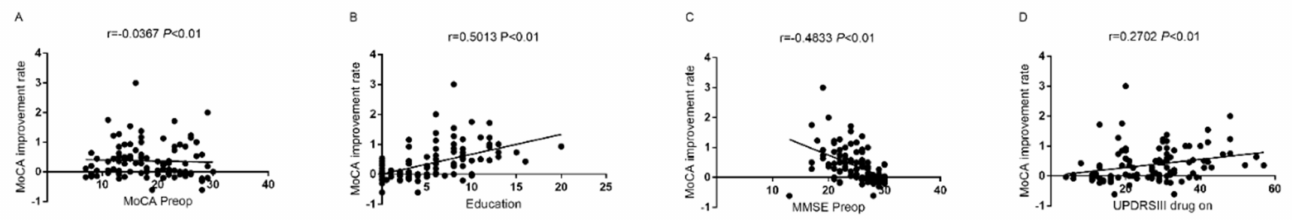
Figure 3. Correlations of MoCA score improvement rate with MoCA preop ( A ), education ( B ), MMSE preop ( C ) and UPDRSIII drug on ( D